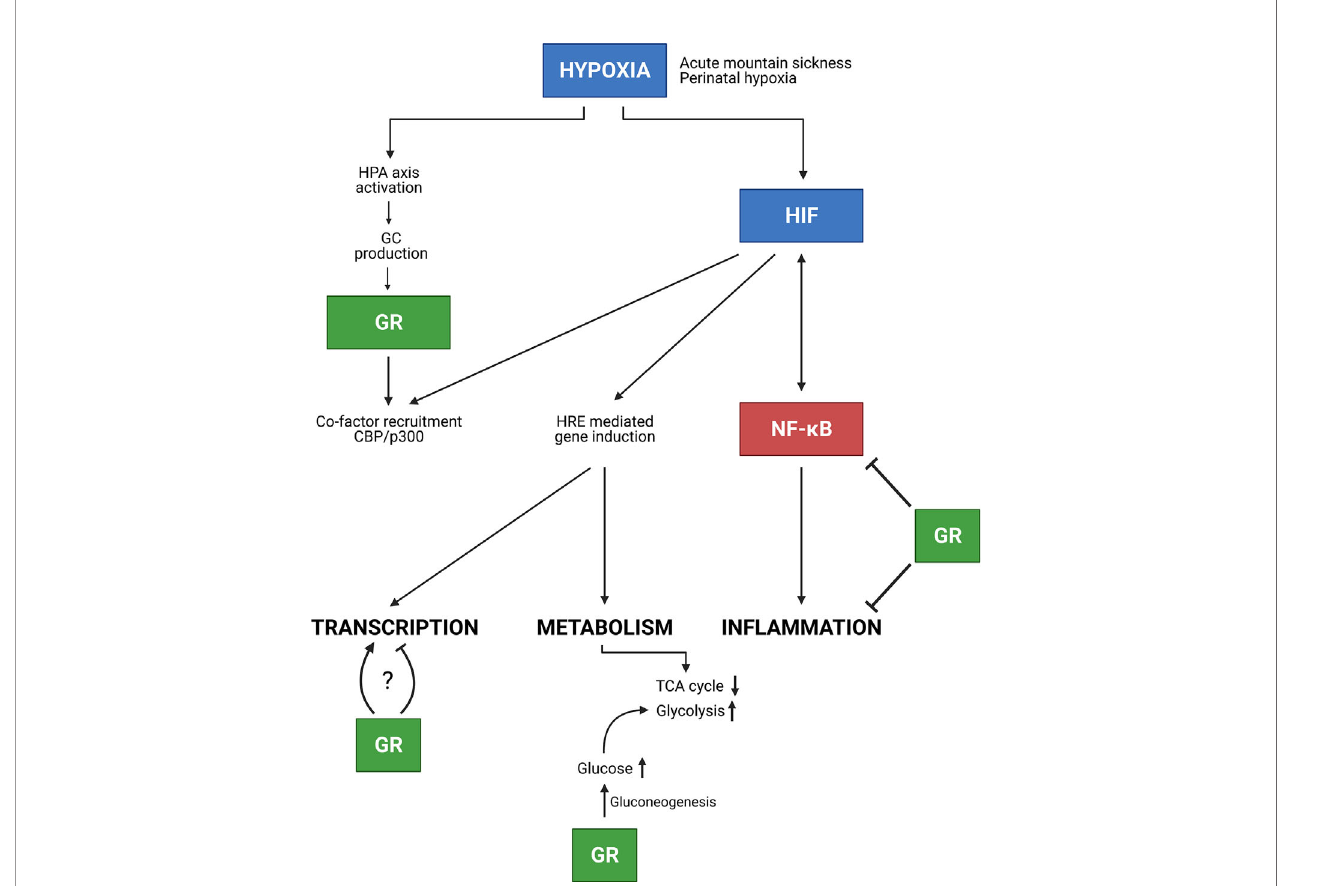
FIGURE 9 | Conclusion. In the presence of hypoxia e.g. due to AMS or neonatal hypoxia, the HPA axis is activated thereby increasing GC production and GR mediated effects. Next to GR, HIF is involved in NF- k B in fl ammatory responses, in which these responses can be inhibited by GR. Furthermore, HIF mediated transcription is stimulated, but GR competes with HIF in the recruitment of co-factors e.g. CBP/p300. Whether GR stimulates or inhibits HIF mediated transcription requires further investigation. Finally, hypoxia also causes metabolic changes. The GR promotes gluconeogenesis thereby increasing glucose levels which will be used during glycolysis for appropriate energy levels in hypoxic conditions. Figures created with